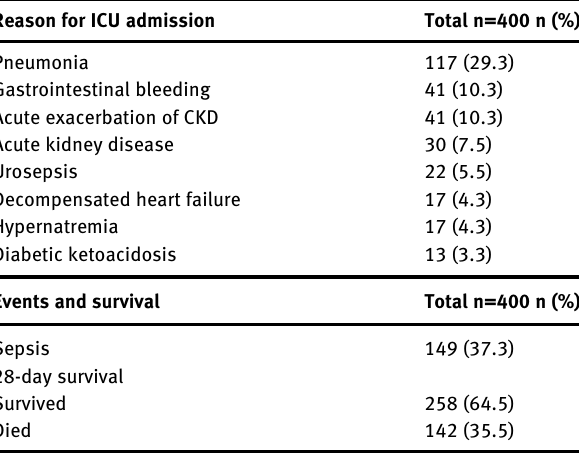
Table  : Reasons for ICU admission and ICU sepsis incidence and survival outcomes.